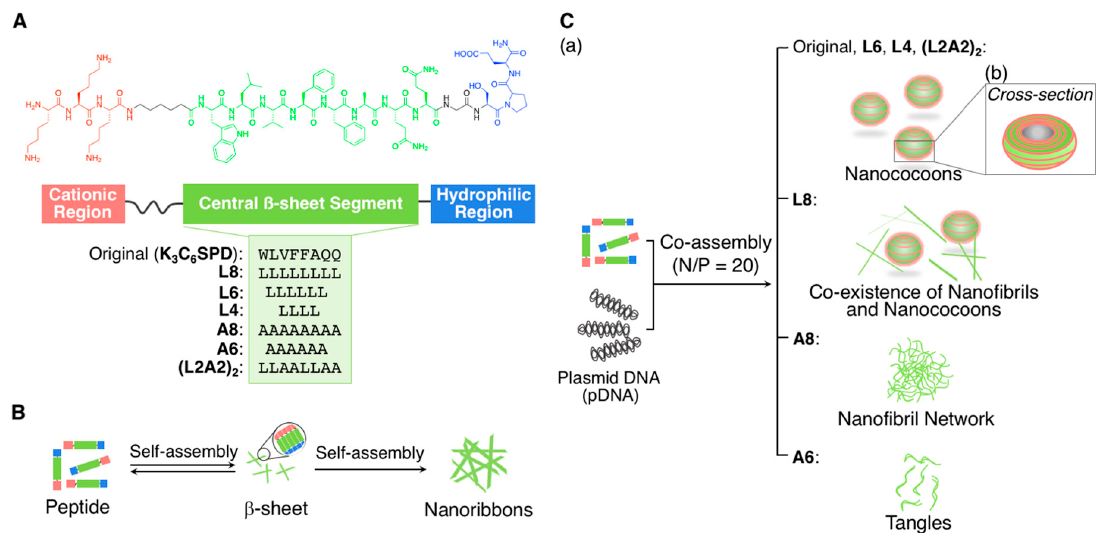
Figure 2. ( A ) Chemical structure of the self-assembling peptide derivatives containing K 3 , a self-assembling β -sheet domain, and a hydrophilic segment at the C-terminus for controlled water dispersibility. ( B ) Schematic illustration of the self-assembly of the peptide derivatives to form the nanoribbons. ( C ) ( a ) Schematic illustration of the co-assembly of the peptide derivatives with plasmid DNA (pDNA) to form a variety of hybrid nanostructures. ( b ) Cross-sectional view of the nanococoons. Adapted from [58]. Copyright 2014 American Chemical Society. Adapted from [59].